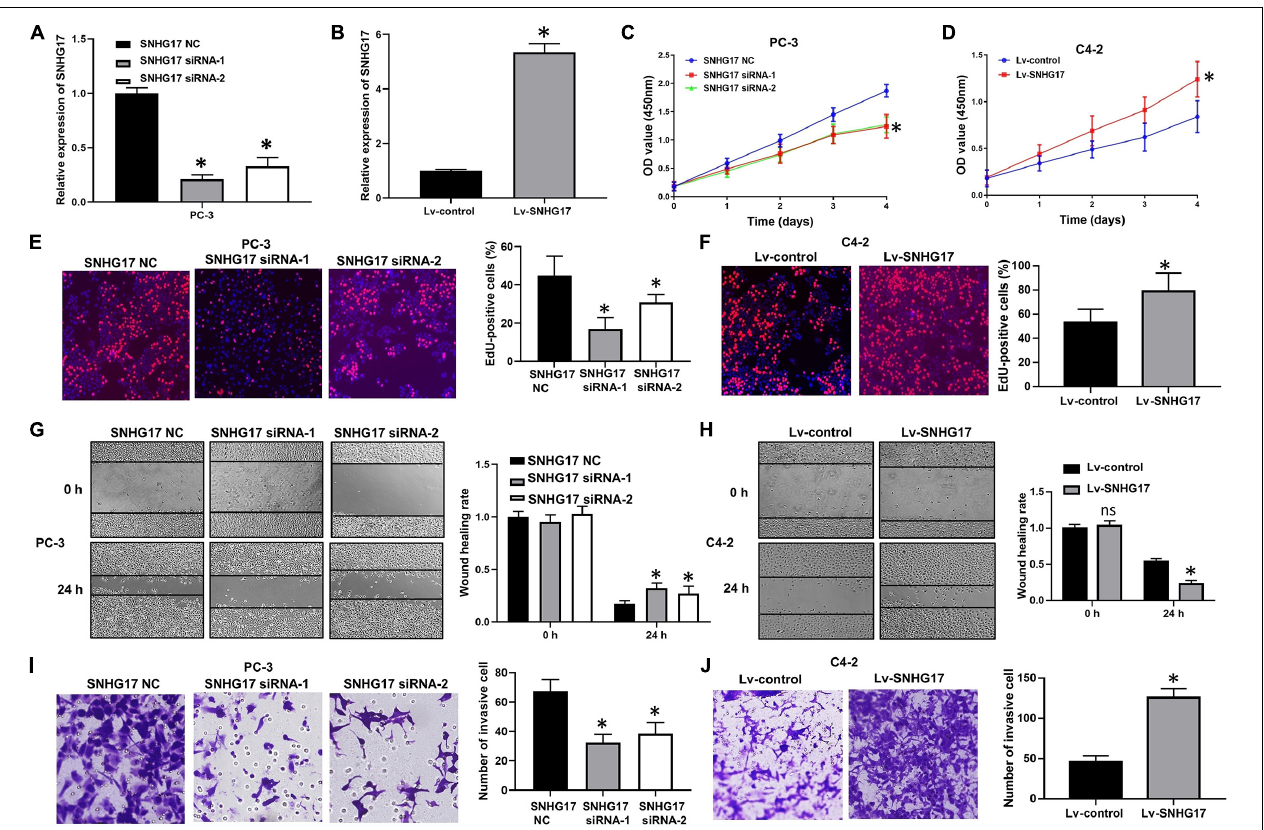
FIGURE 2 | Effects of SNHG17 on cell proliferation and invasion of PC-3 cells in vitro . (A) The transfection efficacy of SNHG17 siRNAs in PC-3 cells, as detected by RT-QPCR; (B) Transfection efficacy of Lv-SNHG17 in C4-2 cells, as confirmed by RT-QPCR; (C) Effects of SNHG17 knockdown on the proliferation of PC-3 cells, as detected by CCK-8 assay; (D) Effects of SNHG17 overexpression on the proliferation of C4-2 cells, as detected by CCK-8 assay; (E) Effects of SNHG17 knockdown on the proliferation of PC-3 cells, as detected by EdU assay; (F) Effects of SNHG17 overexpression on the proliferation of C4-2 cells, as detected by EdU assay; (G) Effects of SNHG17 knockdown on the migration of PC-3 cells, as detected by the wound healing assay; (H) Effects of SNHG17 overexpression on cell migration of C4-2 cells, as detected by wound healing assay; (I) Effects of SNHG17 knockdown on the invasion of PC-3 cells, as detected by transwell assay; (J) Effects of SNHG17 overexpression on cell invasion of C4-2 cells, as detected by transwell assay. Data are shown as the mean ± SE . * P < 0.05, ns, not significant. The representative results of three independent experiments are